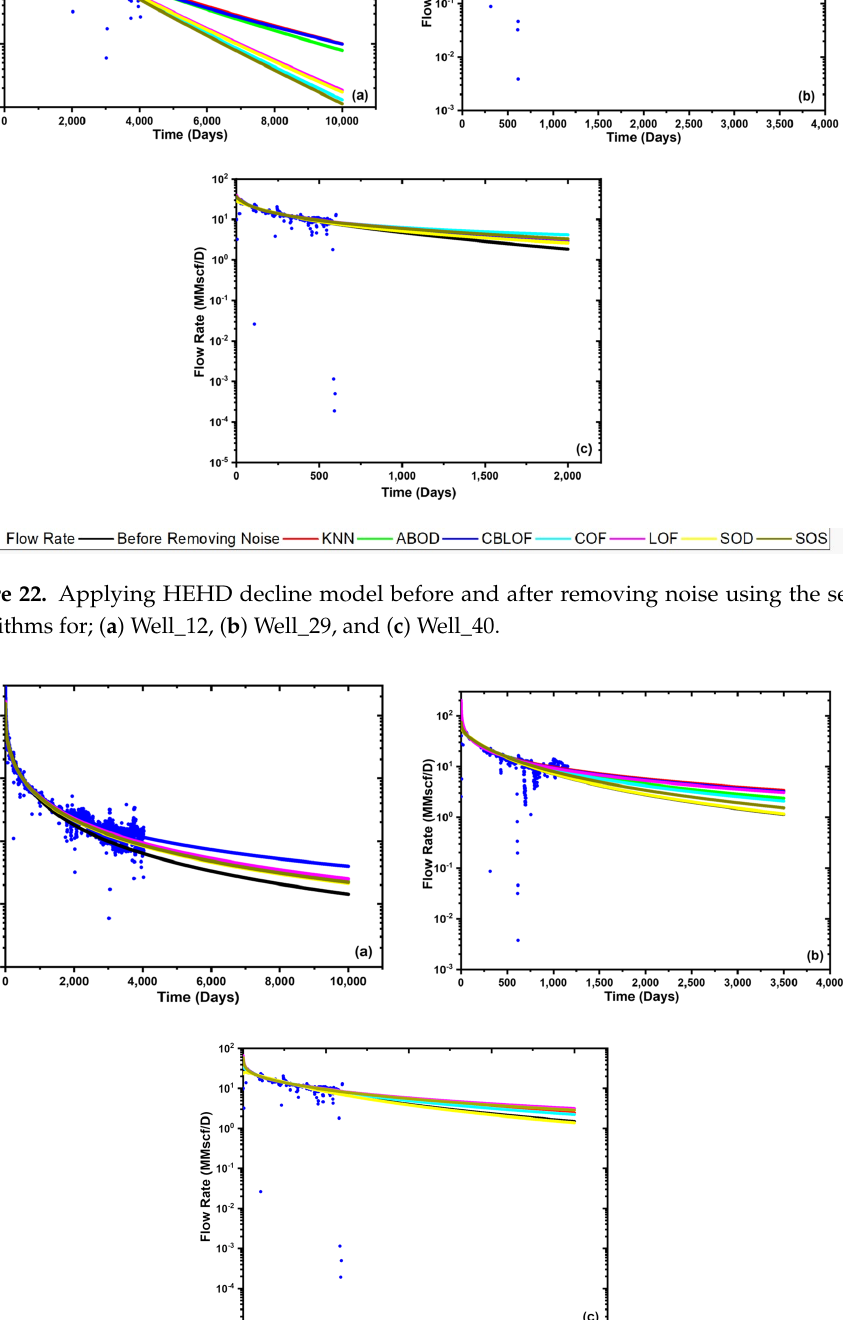
Figure 23. Applying LGM decline model before and after removing noise using the seven OD al ‐ gorithms for; ( a ) Well_12, ( b ) Well_29, and ( c ) Well_40.